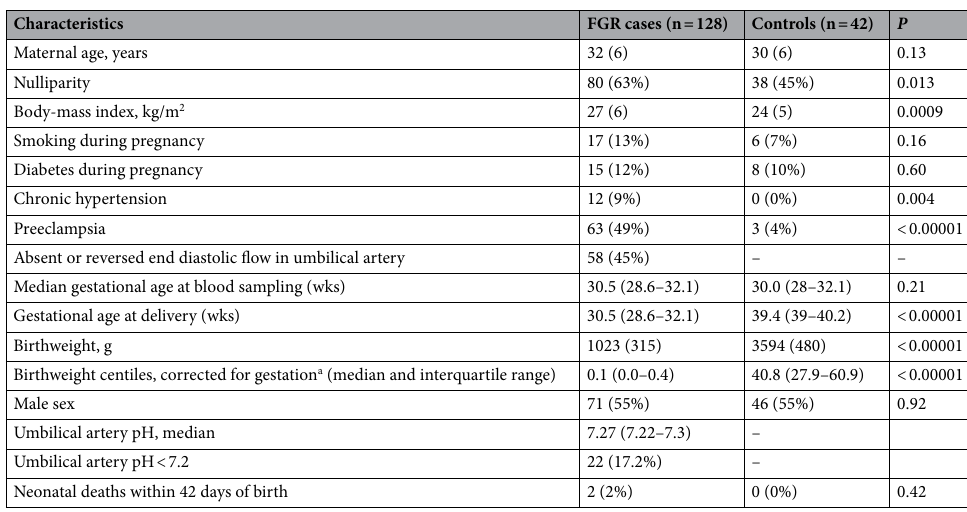
Table 1. Patient characteristics for cases of Fetal Growth Restriction (FGR) and control cohorts as part of the FOX study. Data are n (%), mean (SD), or median (IQR). Comparison between FGR cases and gestation matched controls is by chi squared analysis and t -test. Each control contributed two blood samples for the analysis, at 28 and 32 weeks gestation. This was done to correct for possible changes in RNA concentrations across gestational age. a We used fetal weight reference charts to determine centiles (Hadlock formula, except fetal sex was corrected for).